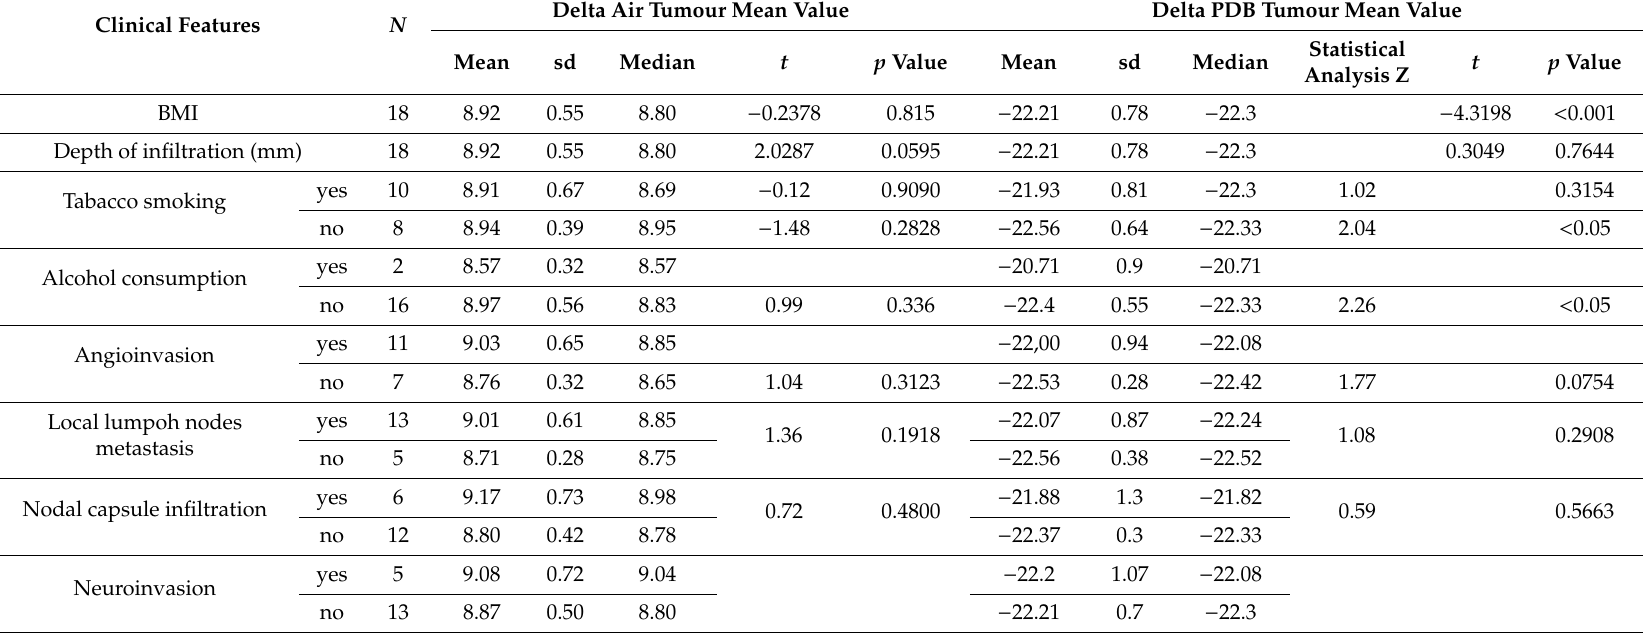
Table 6. Comparison of 15 N / 14 N and 13 C / 12 C isotope ratio estimation in tumour and margin and clinical